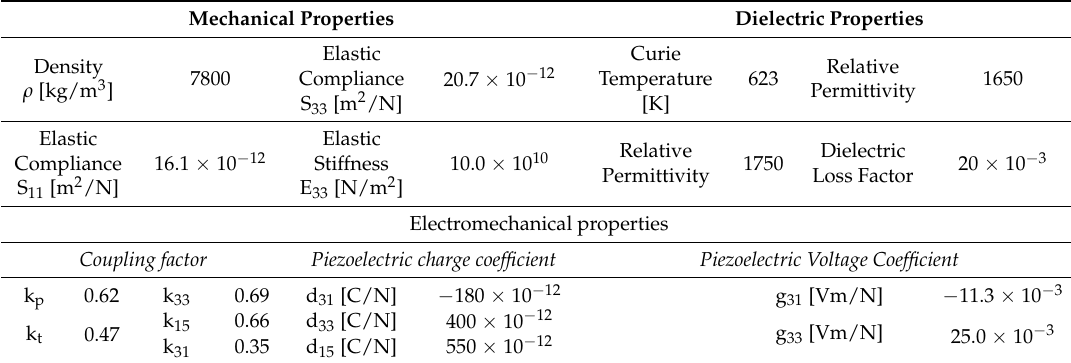
Figure 3. Characteristic Length (C.L.) of damaged sensor. Table 1. Properties of PIC255